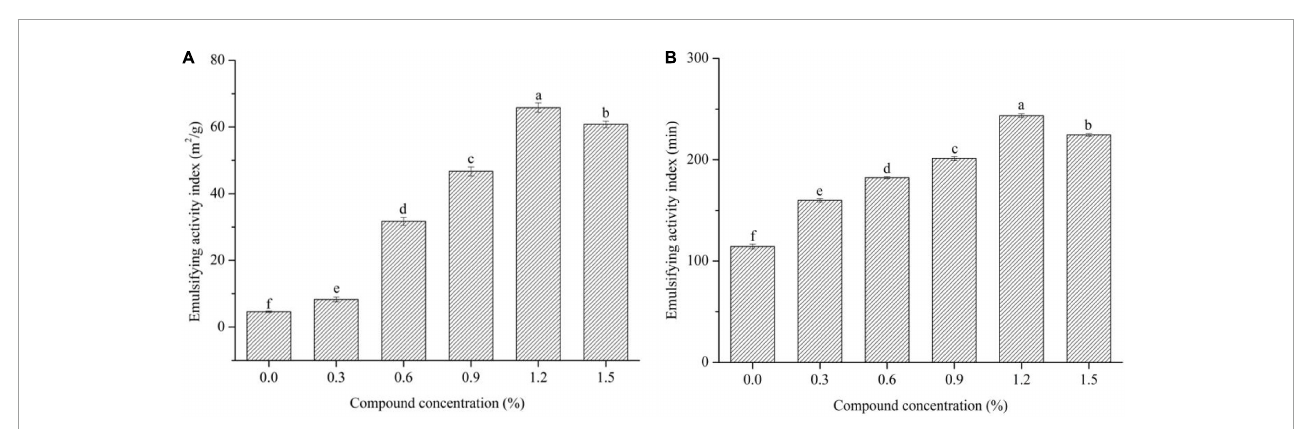
FIGURE3 The EAI (A) and ESI (B) values of the emulsions with different levels of compound fibers. The data are expressed as the mean ± standard error. Values with different lowercase letters are significantly different ( P < 0.05).